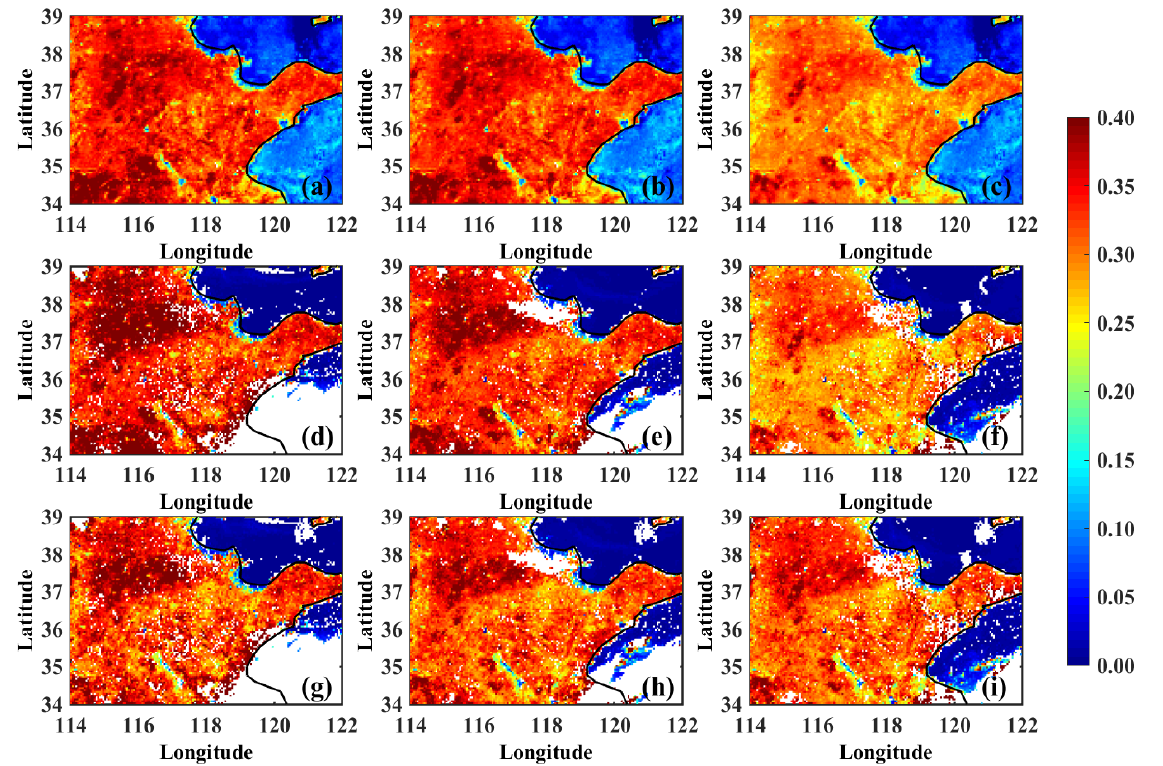
Figure 7. ( a – c ) are the AHI near-infrared band reflectance at 00:00 UTC, 02:00 UTC and 04:00 UTC on 1 July 2019 computed from MCD43 coefficient, respectively. ( d – f ) correspond to the reflectance after atmospheric correction. ( g – i ) are the reflectance after both atmospheric and angle corrections.